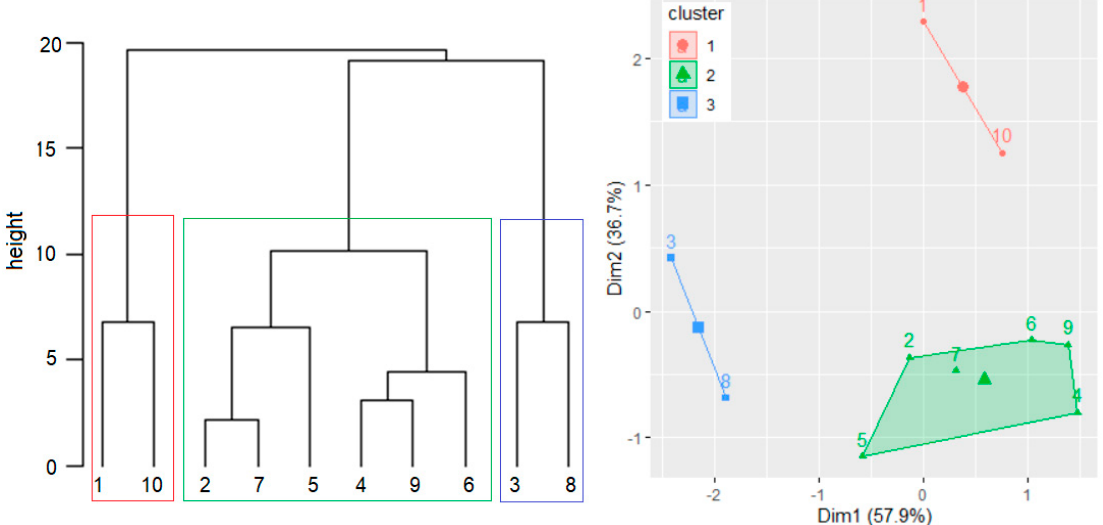
Figure 6. Dendrogram and clusters built using the WQIs from S1–S10.